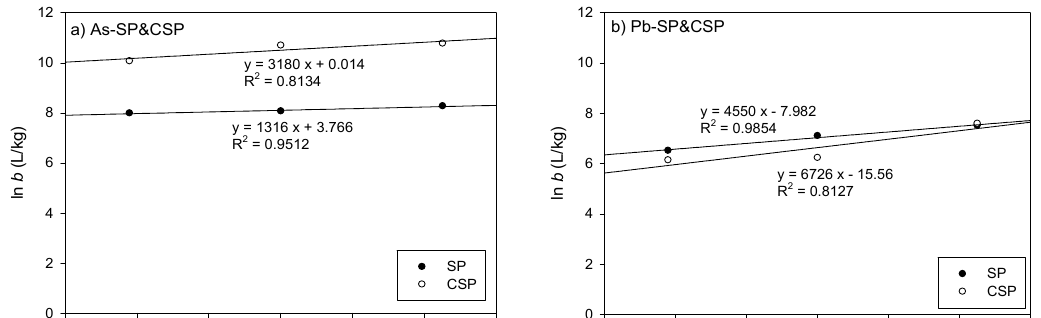
Figure 6. Relationship between ( a ) q mL and q mD , and ( b ) ln b and E .